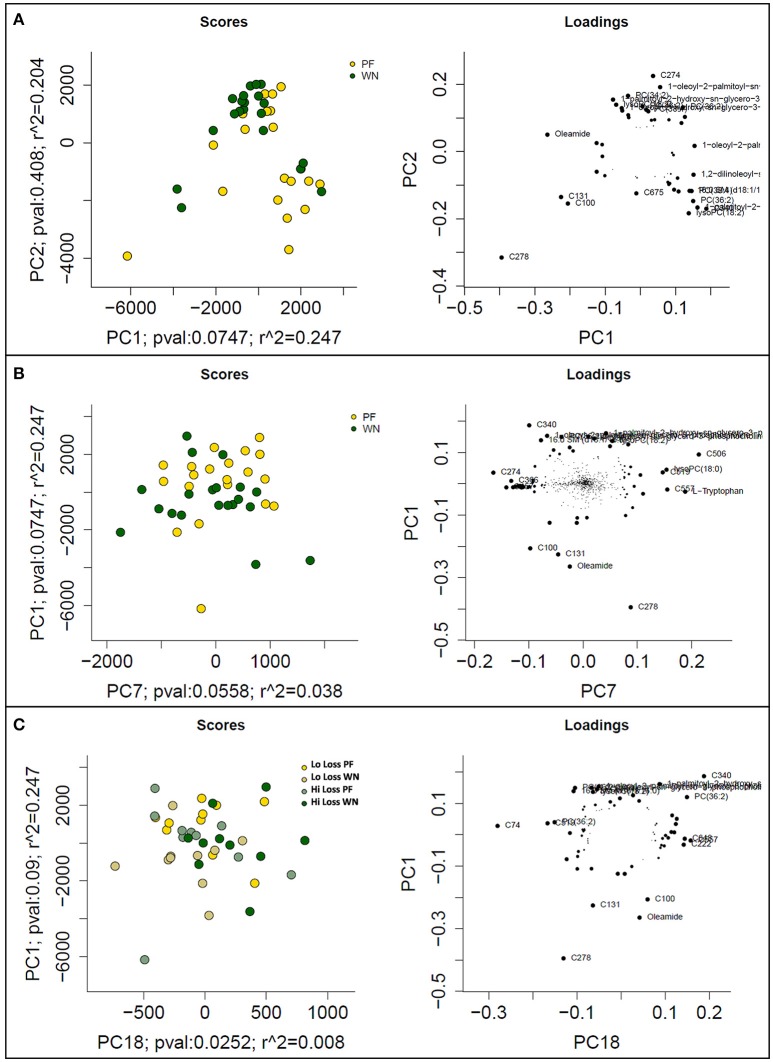
PCA score plots (left) and loadings plots (right) from mean-centered and Pareto scaled LC-MS dataset. (A) depicts the maximal variance, plotting PC1 vs. PC2, (B) represents optimal separation based on time of collection (post-farrowing or weaning), and (C) represents optimal separation by body condition loss (lo loss or hi loss) with respect to time of sampling (post-farrowing or weaning).